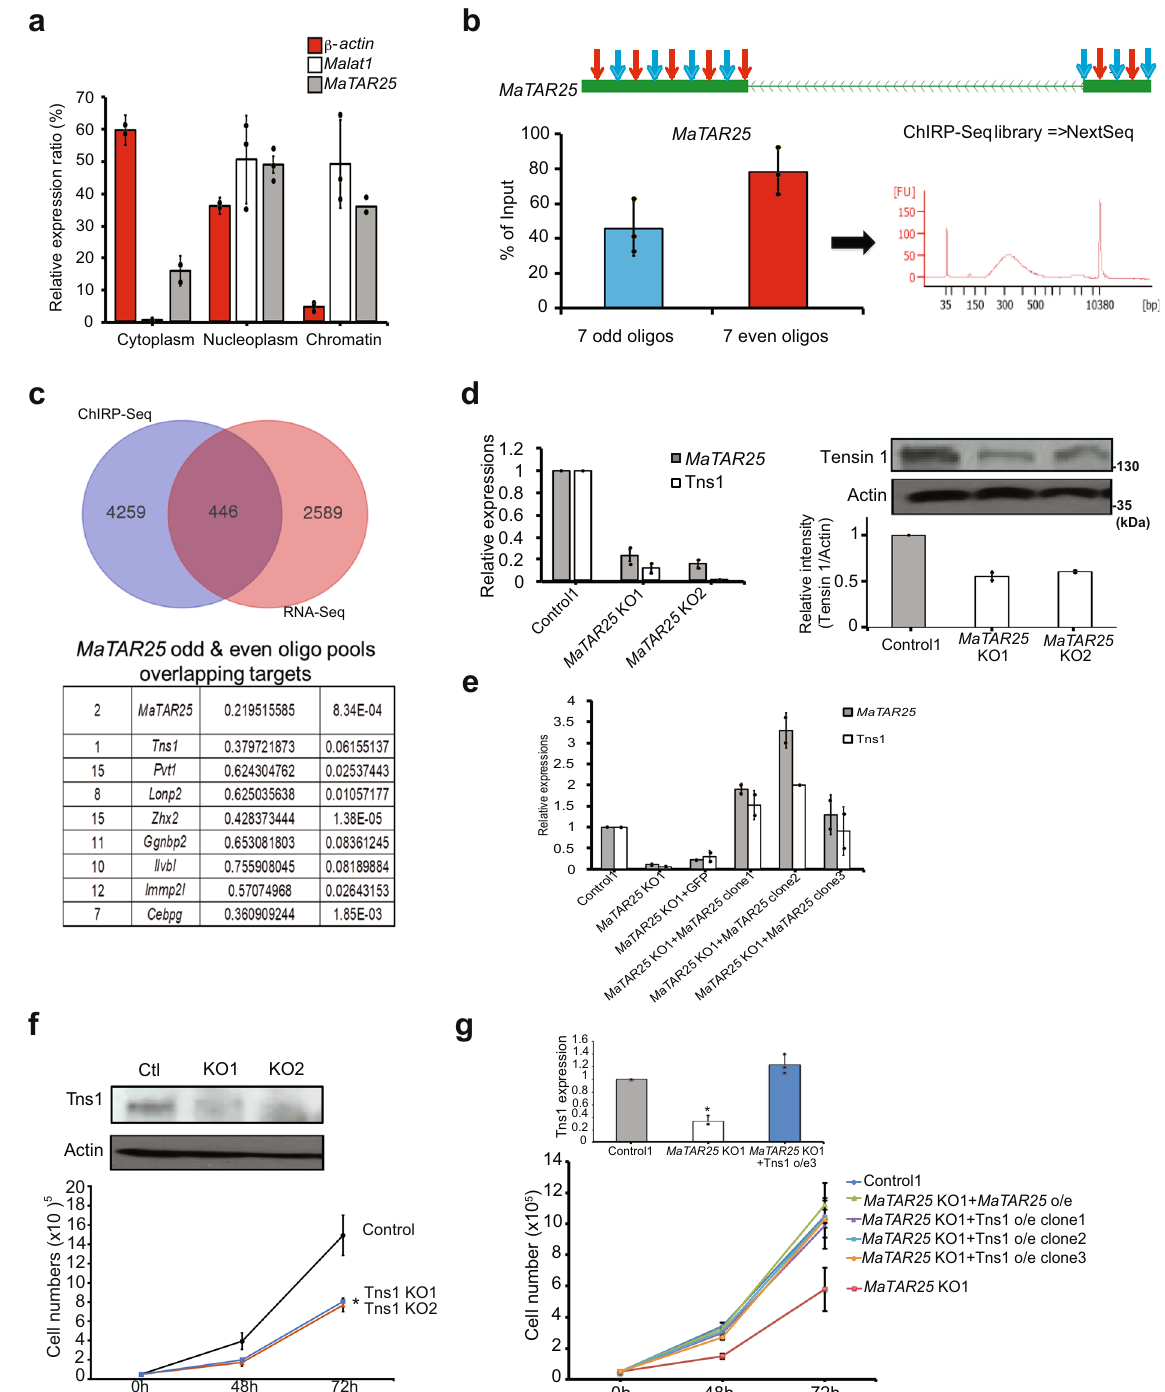
results from MaTAR25 ASO1-mediated KD in 4T1 and cNeu MaTAR25 RNA levels (Supplementary Fig. 4d). Interestingly, ectopic expression of MaTAR25 in MaTAR25 KO cells results in a corresponding increase in the level of Tns1 (Fig. 4e). Hence,